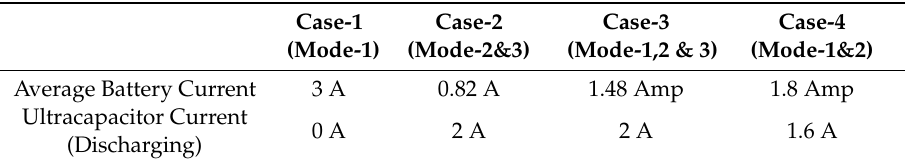
Table 6. Current comparison for di ff erent